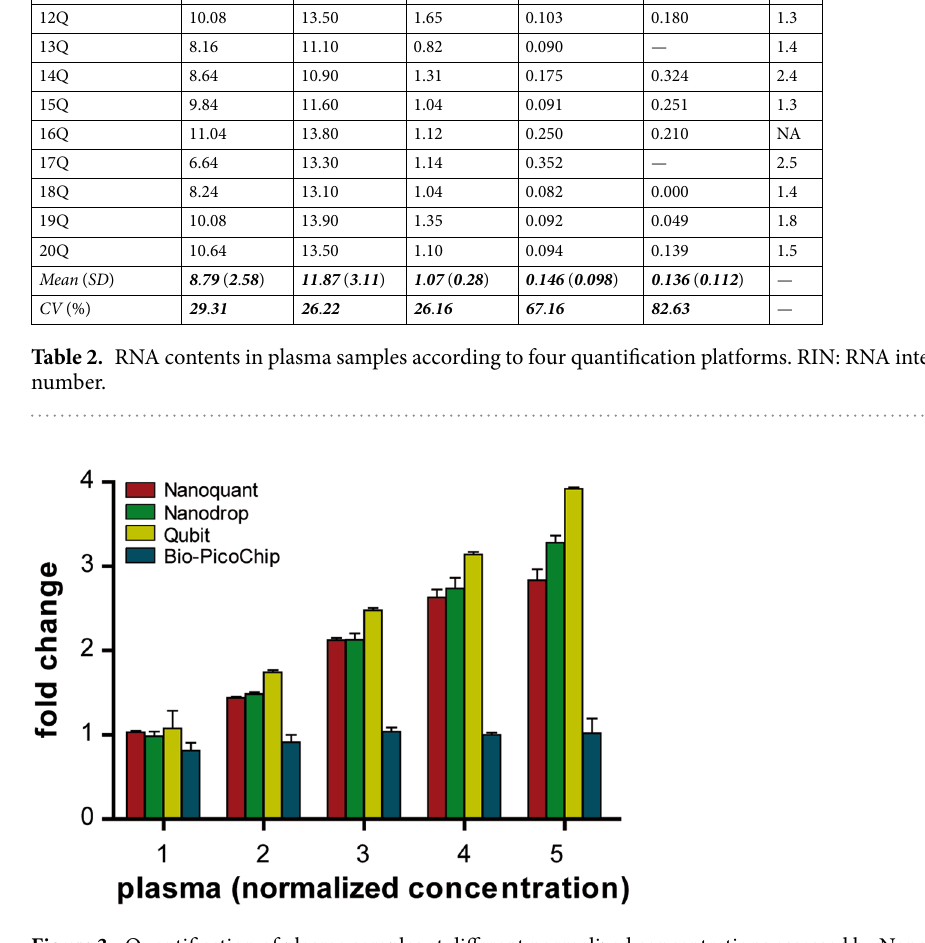
Figure 3. Quantification of plasma samples at different normalized concentrations assessed by Nanoquant, Nanodrop, Qubit and Bio-PicoChip. Evaluation of the performance of the four quantification techniques in a series of five increasing concentrations prepared from the pooled plasma. Data on the X axis are normalized to the lowest concentration (data in Supplementary Table S3). Bio-PicoChip results showed high variability and did not increase proportionally with increasing